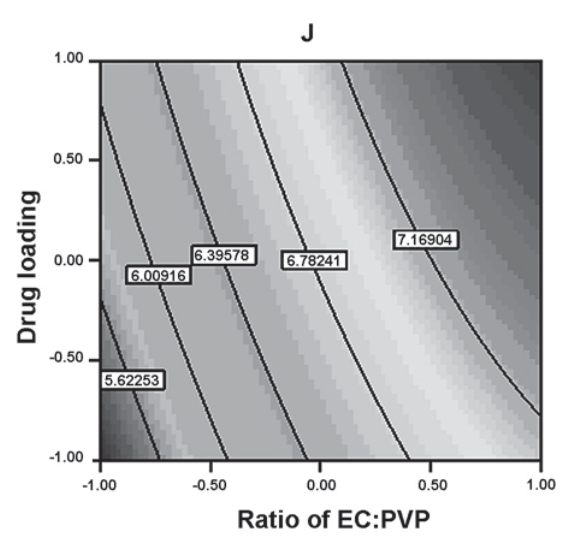
Figure 6 – Contour plot for permeation flux (J) indicating the effect of the ratio of EC: PVP and drug loading on J.